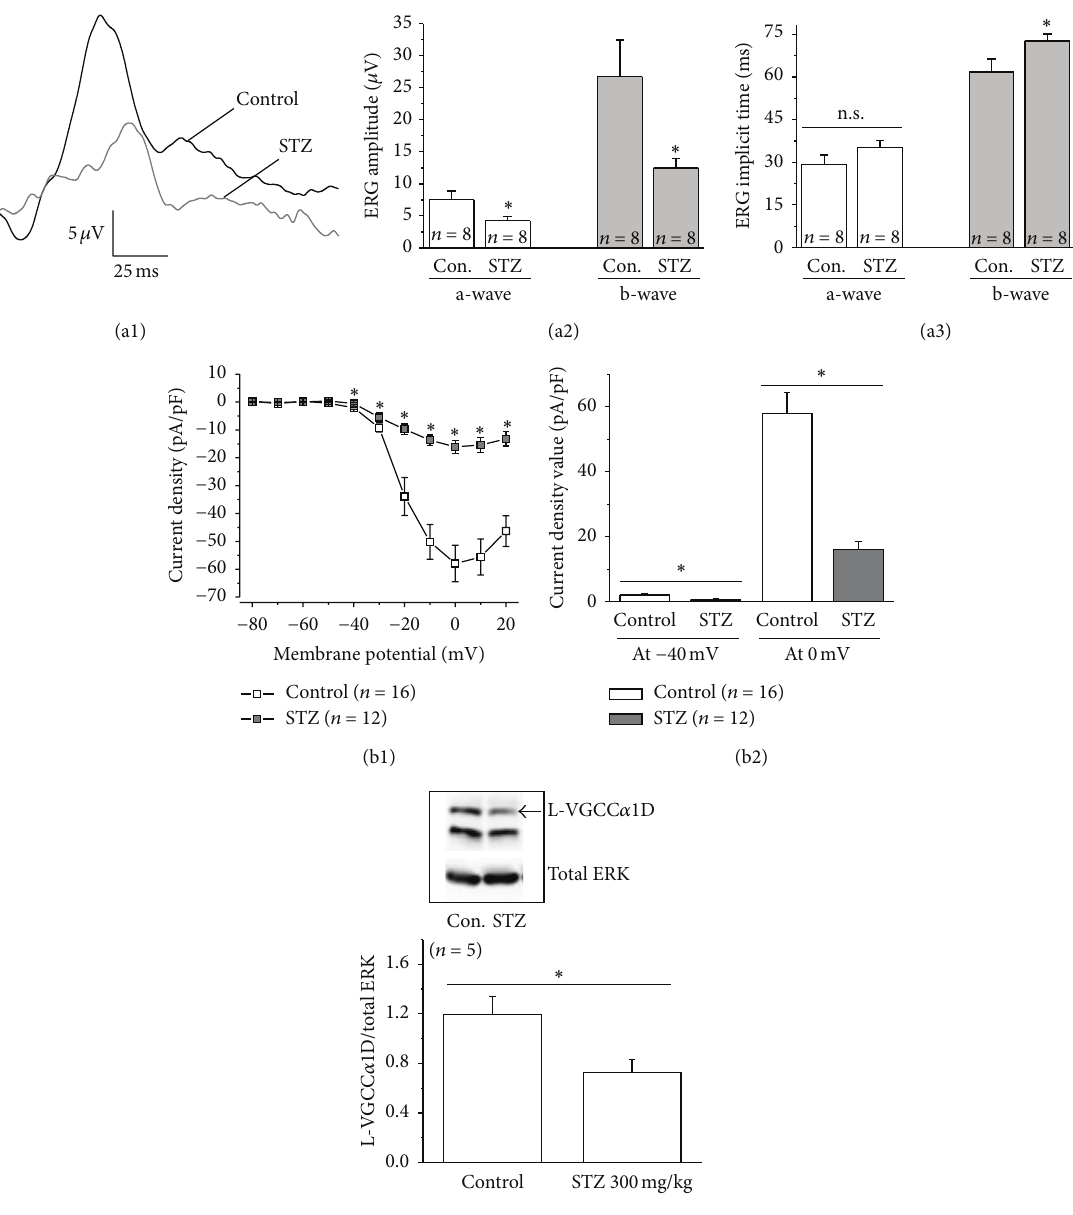
Figure 4: The STZ-induced diabetic retina exhibits changed physiology. (a1-a3) ERGs were recorded from E20 embryos. (a1) Representative ERGwaveformsfromacontrolandaSTZ-injectedembryo.(a2)Theamplitudesofa-andb-wavesfromSTZ-injectedembryosaresignificantly lower than the ones recorded from controls. (a3) The implicit time of both a- and b-waves from STZ-injected embryos are delayed, but there is a significant increase of the b-wave implicit time from STZ-injected embryos compared to the control. (b1-b2) Cone photoreceptors from control and STZ-injected embryonic retinas were dissociated and cultured at E18. The next day, patch-clamp recordings of L-VGCCs were carried out. (b1) The average data of voltage (mV) current density (pA/pF) relationship from the control and STZ-diabetic photoreceptors are shown. (b2) At both − 40mV and 0mV, the L-VGCC current densities are significantly lower from STZ-diabetic photoreceptors compared to the control. (c) The STZ-injected diabetic retina has a significant decrease in the protein level of the L-VGCC 𝛼 1D subunit compared to the control. Total ERK serves as a loading control. ∗ 𝑃 < 0.05